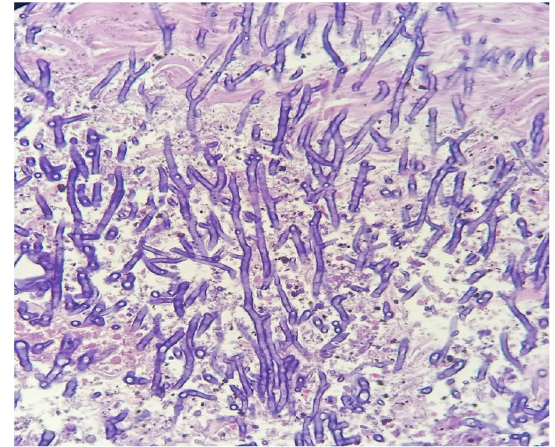
Fig. 4 Histological examination of the debrided pathological tissue with the periodic acid–Schiff technique found septated, dichotomously branched mycelium consistent with Aspergillus